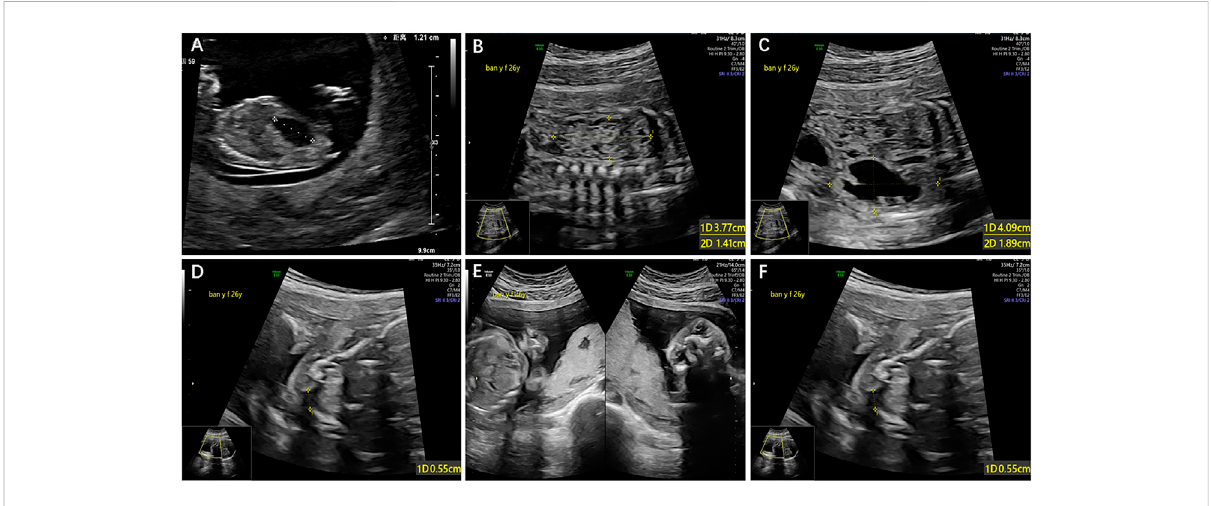
FIGURE 1 (A) :Enlarged bladderwiththediameter of12 mm, (B) rightmulticystickidney, (C) lefthydronephrosis withthewidthof4 cm, (D) cleftpalate, (E) and (F) cleft